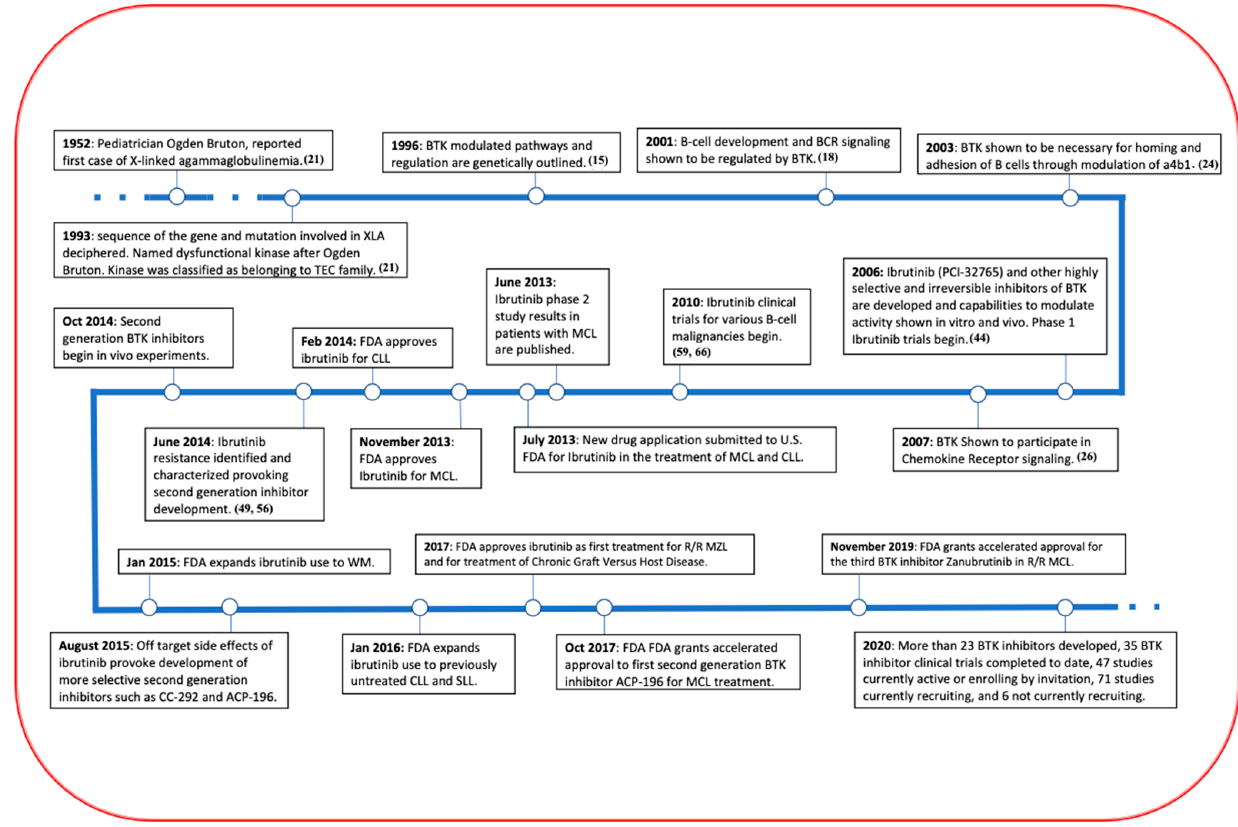
Figure 2. A Timeline of BTK and its inhibitor. BTK has made remarkable progress in the past 10 years in its treatment in a variety of B cell related malignancies and even more clinical trials are underway, including some in MM.